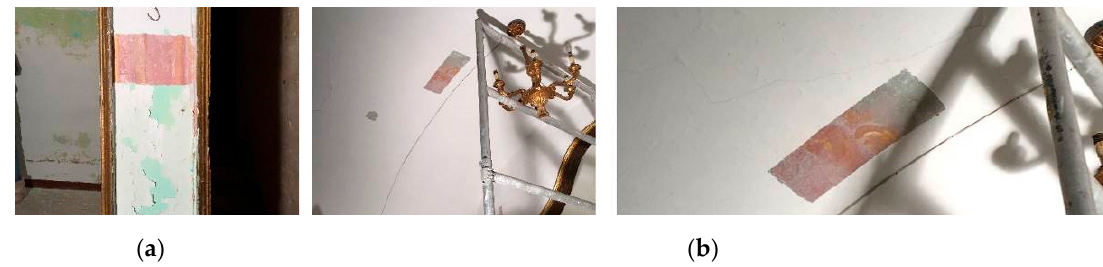
Figure 13. ( a ) Test performed on the wall of the room with the alcove, and ( b ) test performed on the vault of the room with the alcove with detail.